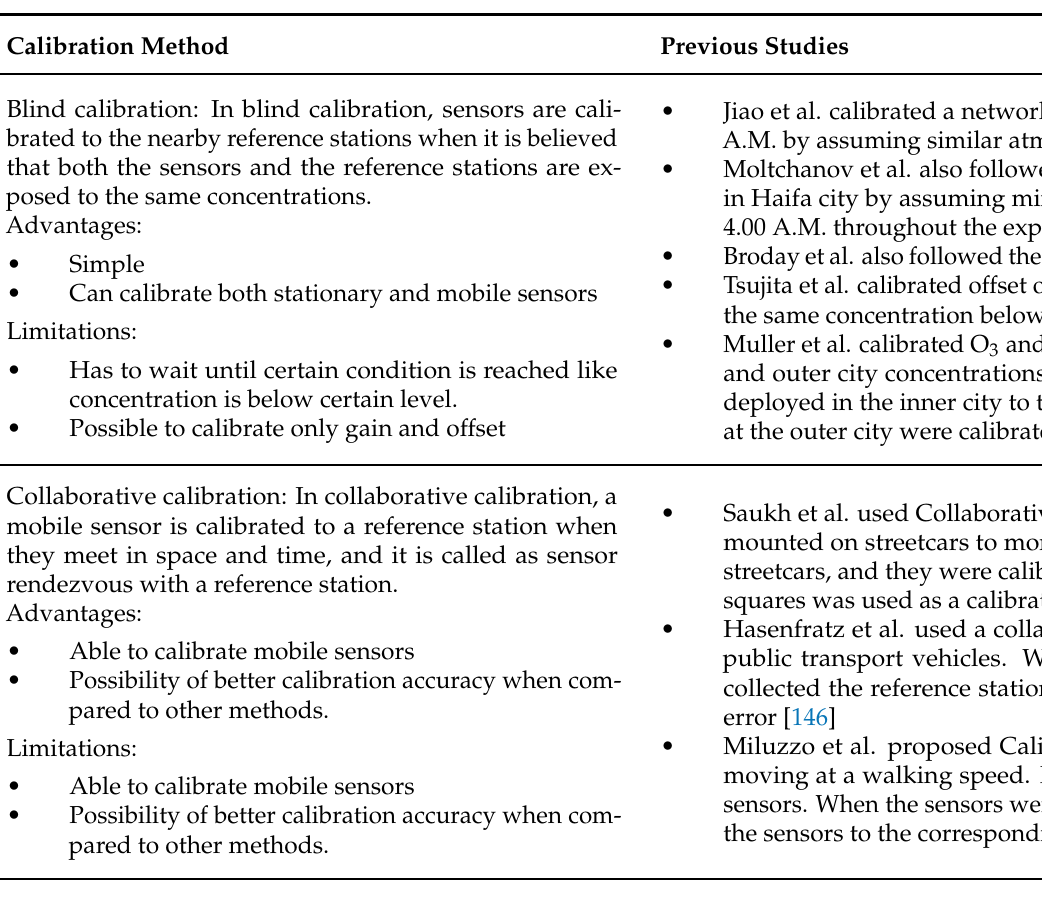
Table 8. Post-deployment calibration